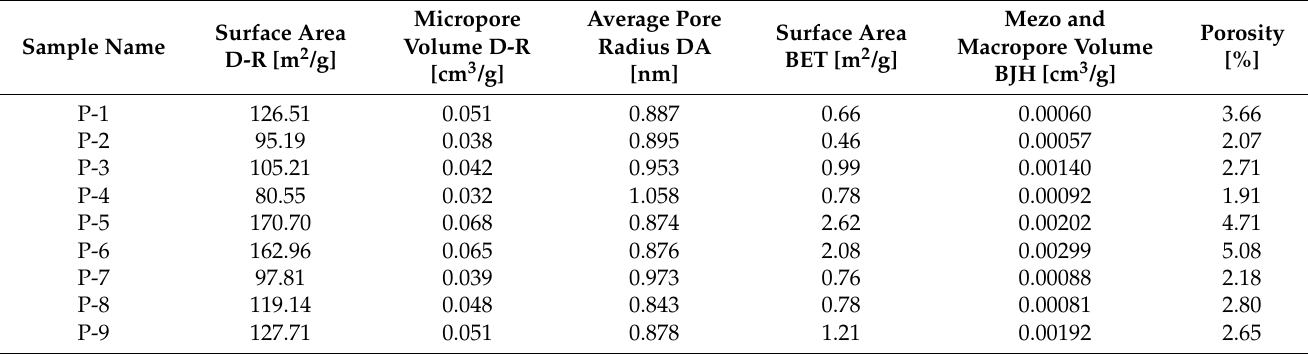
Table 5. Summary of the results of coal structure